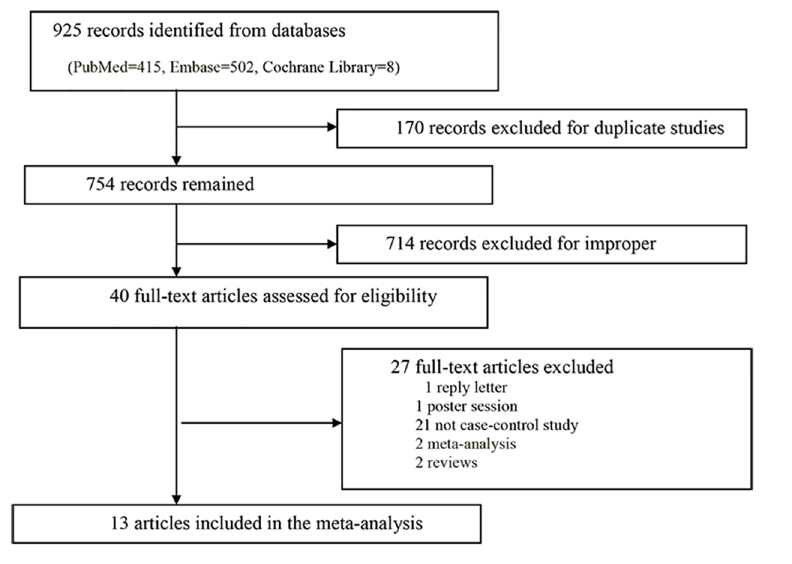
Fig 1. Flow chart of study selection.